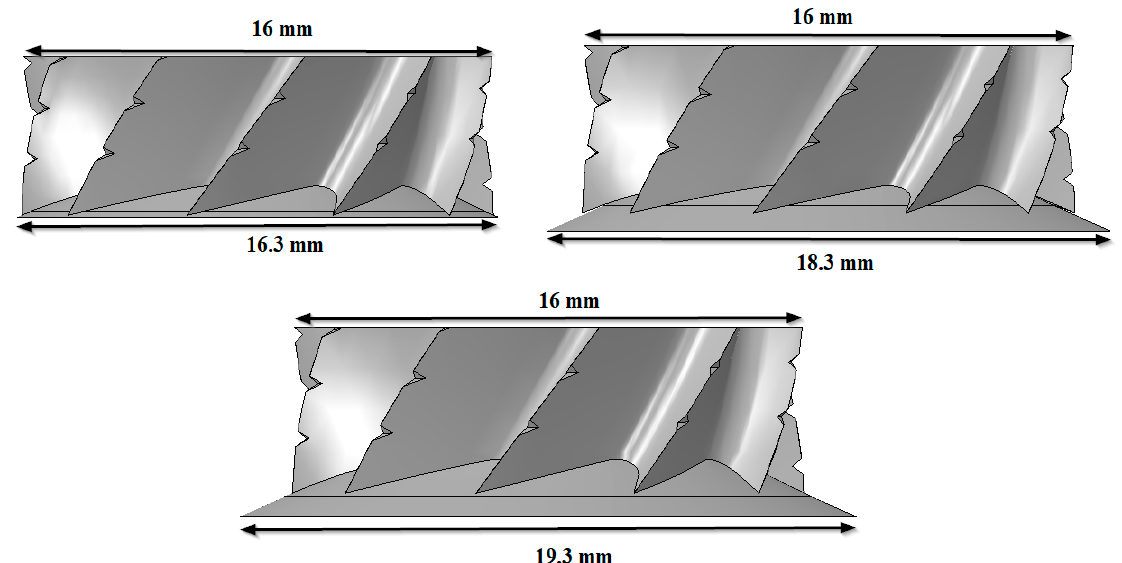
Figure 11. CZ10 cutting tool to different diameters the cutting blade.